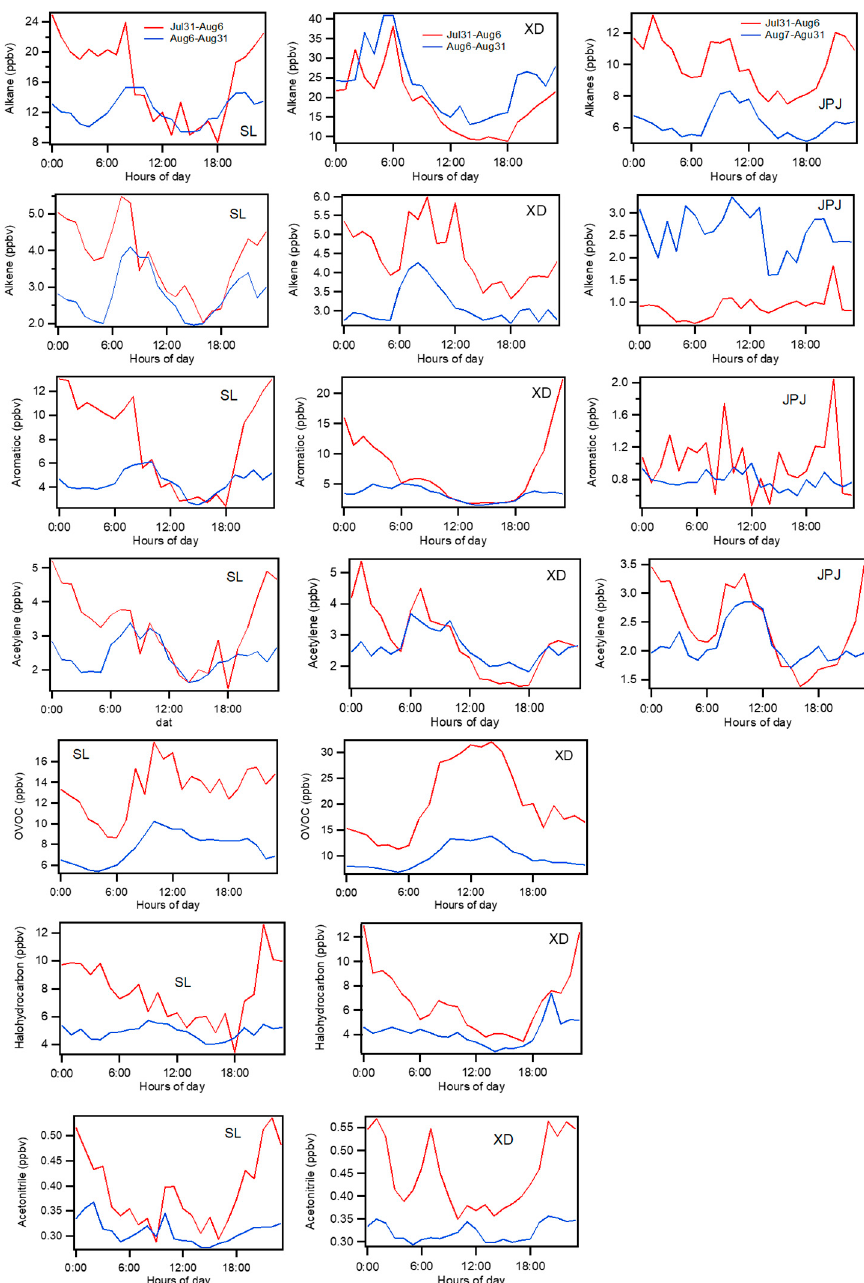
Figure 5. Diurnal variations of VOC groups observed at SL, XD and JPJ before (red line: July 31 – August 6) and during (bule line: August 7 – August 31) control periods.